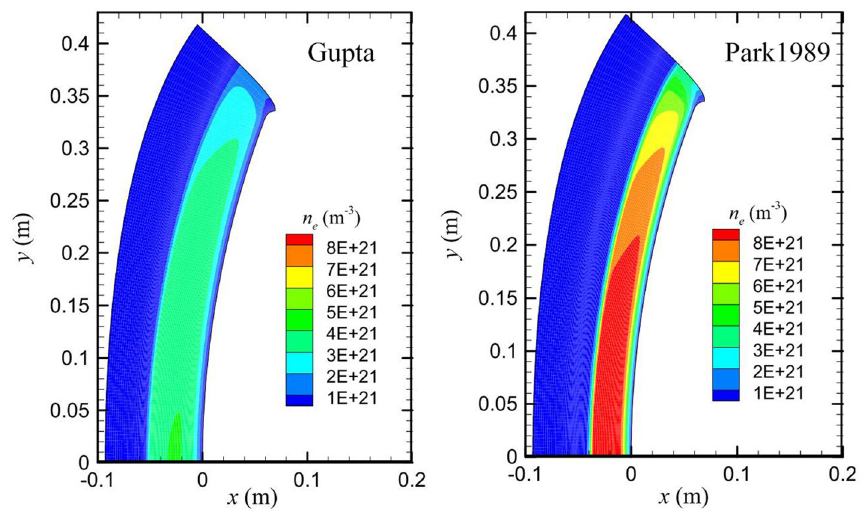
Fig. 8 Electron number density for FIRE II